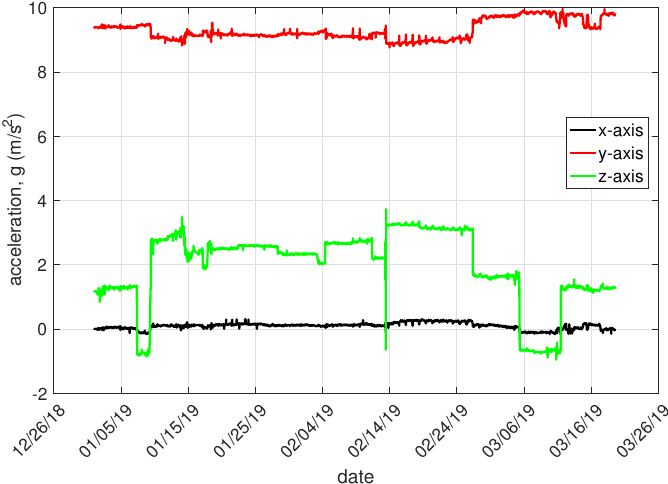
Figure 10. Deflection of the protective fence at the position of accelerometer wireless sensor node No.